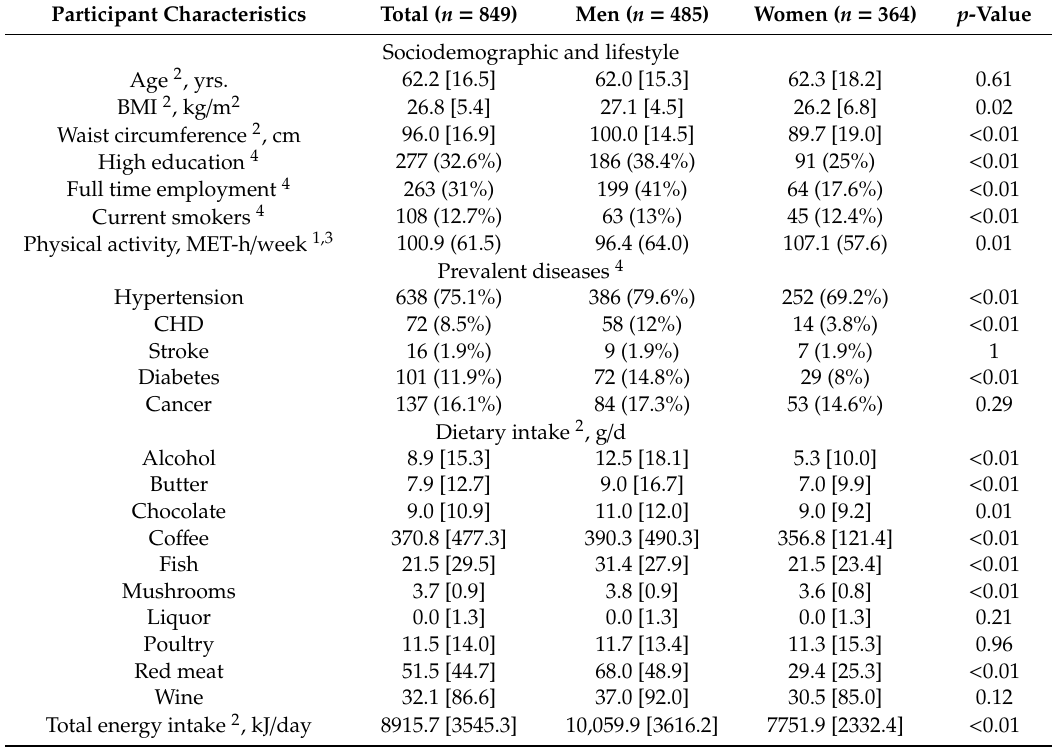
Table 1. Characteristics of the study population at the time of follow-up (2010–2012) in PopGen by sex 1 .